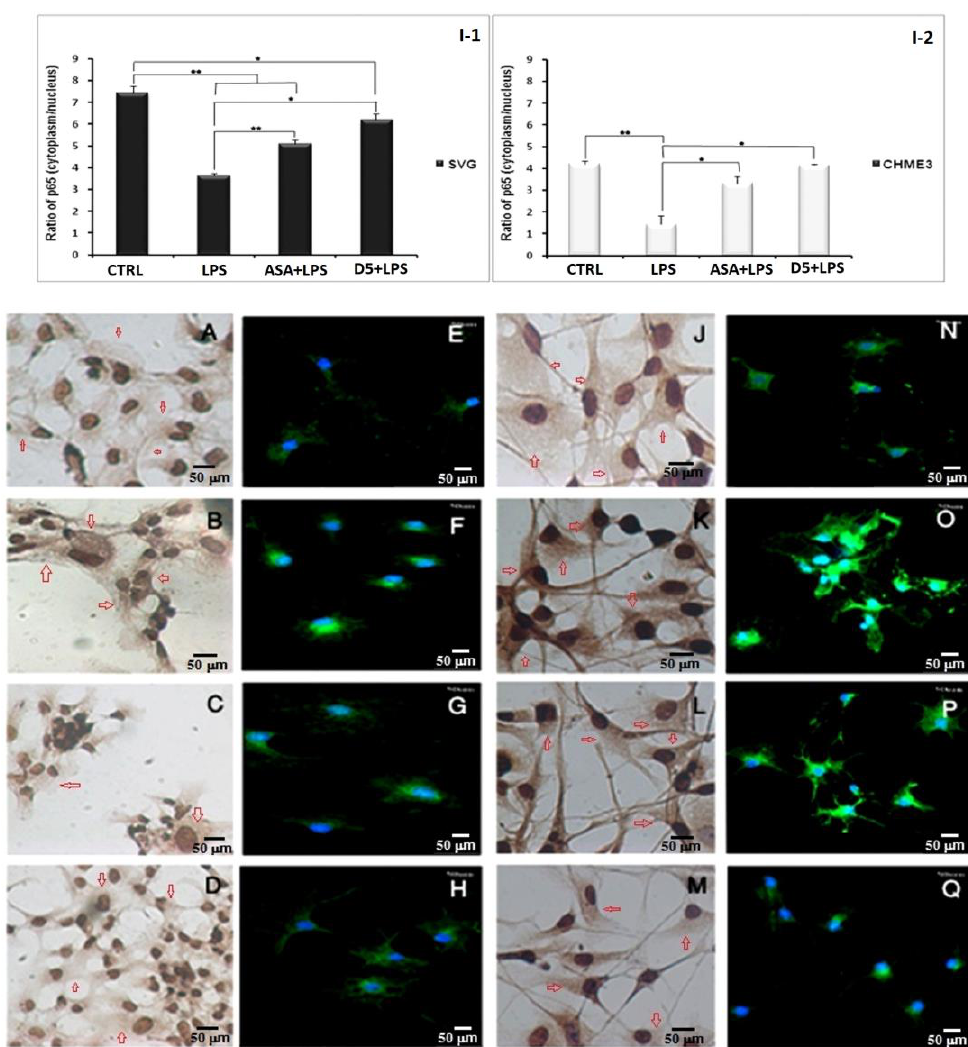
Figure 8. In situ study using immunocytochemistry and immunofluorescence assay to investigate the impact of D5 treatment on silencing NF- κB signaling pathway in LPS -Stimulated astrocyte (SVG) and microglia (CHME3) cell lines:( A – D , J – M ) Representative images of hematoxylin/DAB immunocytochemistry study of the D5 and ASA treatments roles on silencing NF- κB signaling pathway in LPS-Stimulated astrocyte (SVG) and microglia (CHME3) cell lines. Images are shown at 400-fold magnification. The in situ study demonstrated the impact of D5 compared to ASA on the decomposition of NF- κB complex , induced by LPS in the cytosol and subcellular localization of phospho- IκB - α S32. DAB -labeled HRP against Anti-Phospho- IκB alpha (S32) Rabbit Monoclonal Antibody was used to produce brown dots in the peripheral cytoplasm to nuclei (depicted by red arrows in the ICC images), counterstained with Hematoxylin to form dark-blue-to-black stains in control groups of astrocyte ( A ) and microglia cells ( J ). In the LPS-stimulated astrocyte ( B ) and mi- croglia ( K ) groups, phospho-I B alpha(S32) subunit immunoreactivities were shown in the cyto- sol. ASA and D4 treatments significantly protect the IκB - α subunit from phosphorylation and keep the NF- κB complex , in the cytosol of astrocytic glial and microglial cells, in itsinactive form (( G , H )and ( P , Q ), respectively). The level of activated NF- κB -p65 inside the nucleus was measured using a fluorescent-tagged mouse monoclonal NF- κB p65 antibody. The high level of fluorescent signal in the nucleolus of cells is an indicator of the phosphorylation of the IκB - α subunit, break- age of NF- κB complex in the cytosol, activation, translocation of the NF - κB into the nucleus, and binding to chromosomal DNA, resulting in the gene expression of various pro-inflammatory cyto- kines. The immunofluorescence assay of the activated NF- κB -p65 nuclear translocation in both drug-pre-treated SVG and CHME3 cells stimulated with LPS was performed using a 5 µg/mL mouse monoclonal NF- κB p65 antibody (Thermo-Fisher, Poland) and 10 µg/mL goat anti-mouse IgG Alexa Fluor488 (Thermo-Fisher, Poland) as the primary and secondary antibodies, respec-